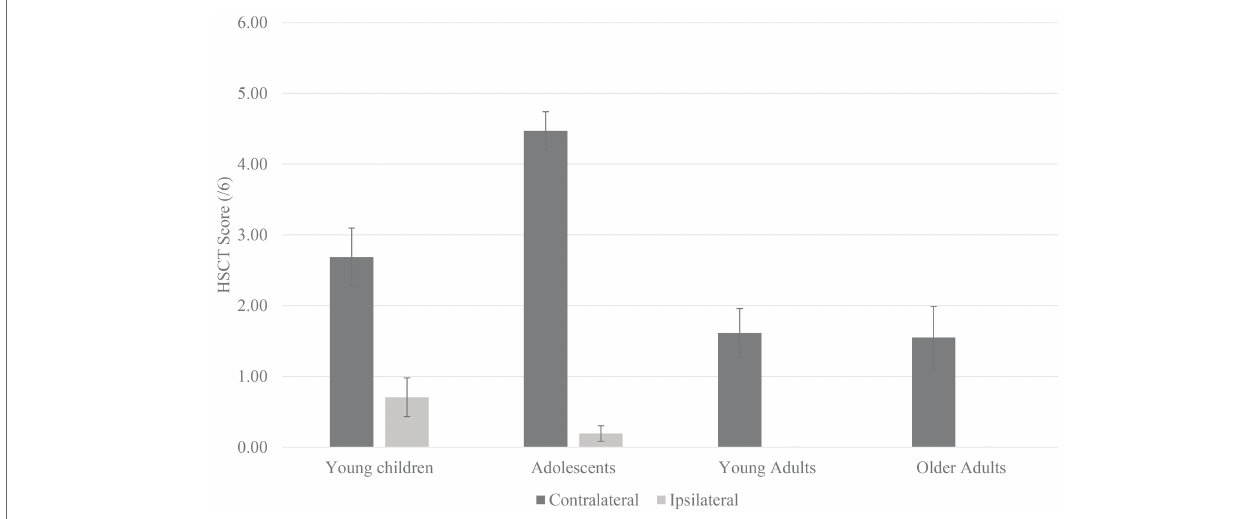
FIGURE 5 | Age was a significant predictor of HSCT switch point. When controlling for WHQ score, the effect of space revealed a higher switch point in contralateral